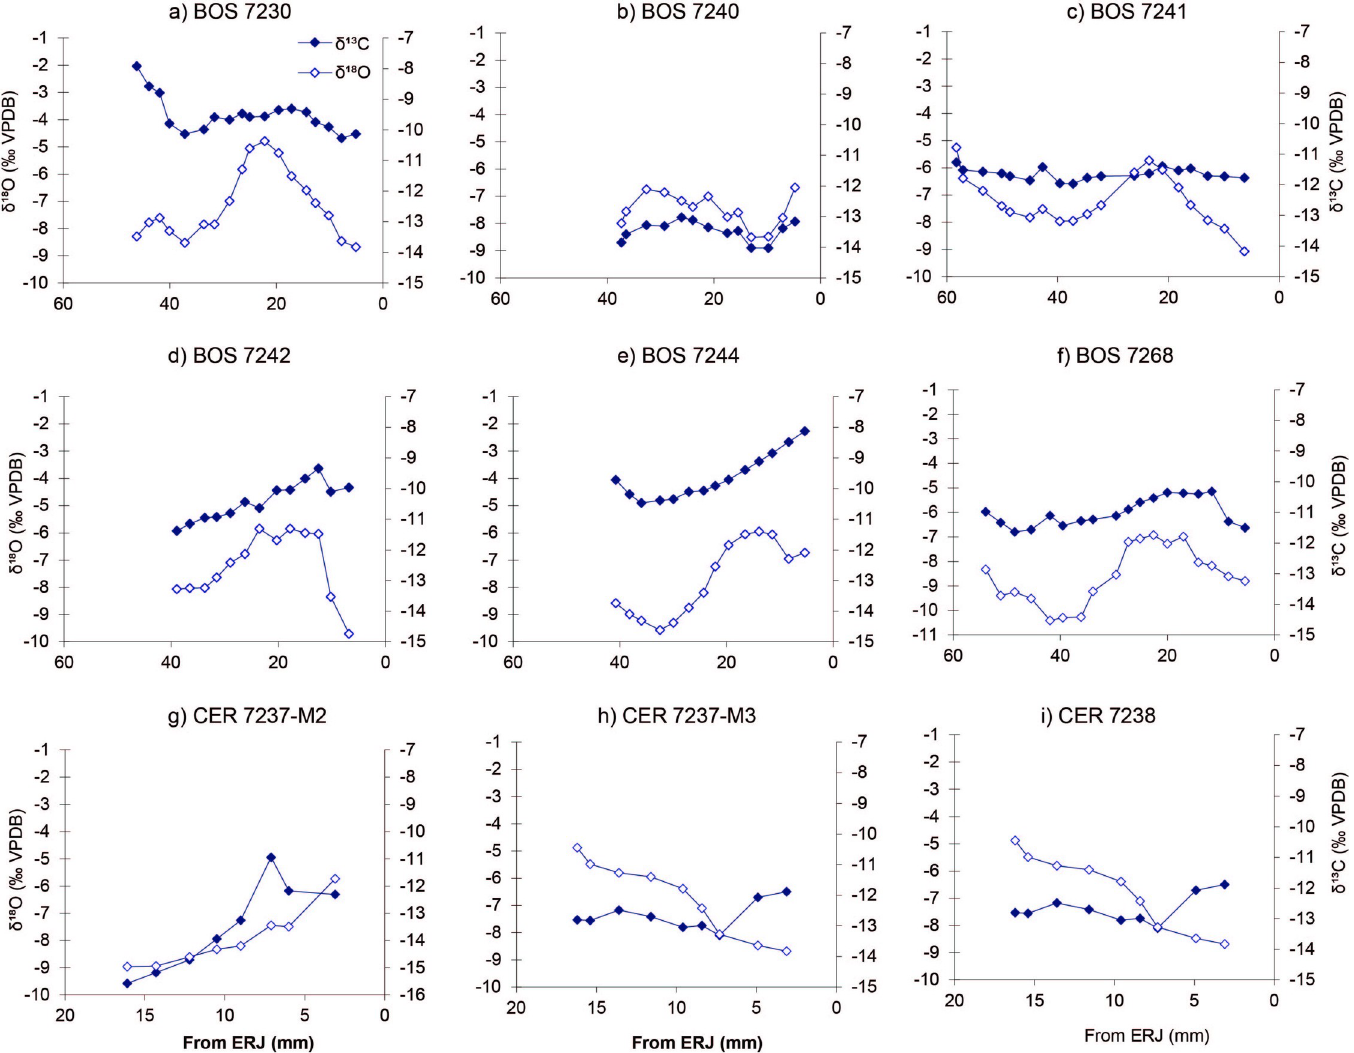
Fig 3. δ 13 C (filled diamond) and δ 18 O (open diamond) values for individual cattle teeth. Insets: a) Bos 7230, b) Bos 7240, c) Bos 7241, d) Bos 7242, e) Bos 7244 (Vin č a- Belo brdo), f) Bos 7268 (Stubline), g) Cervus 7237-M2, h) Cervus 7237-M3 and i) Cervus 7238-M3. ERJ is the enamel root junction.